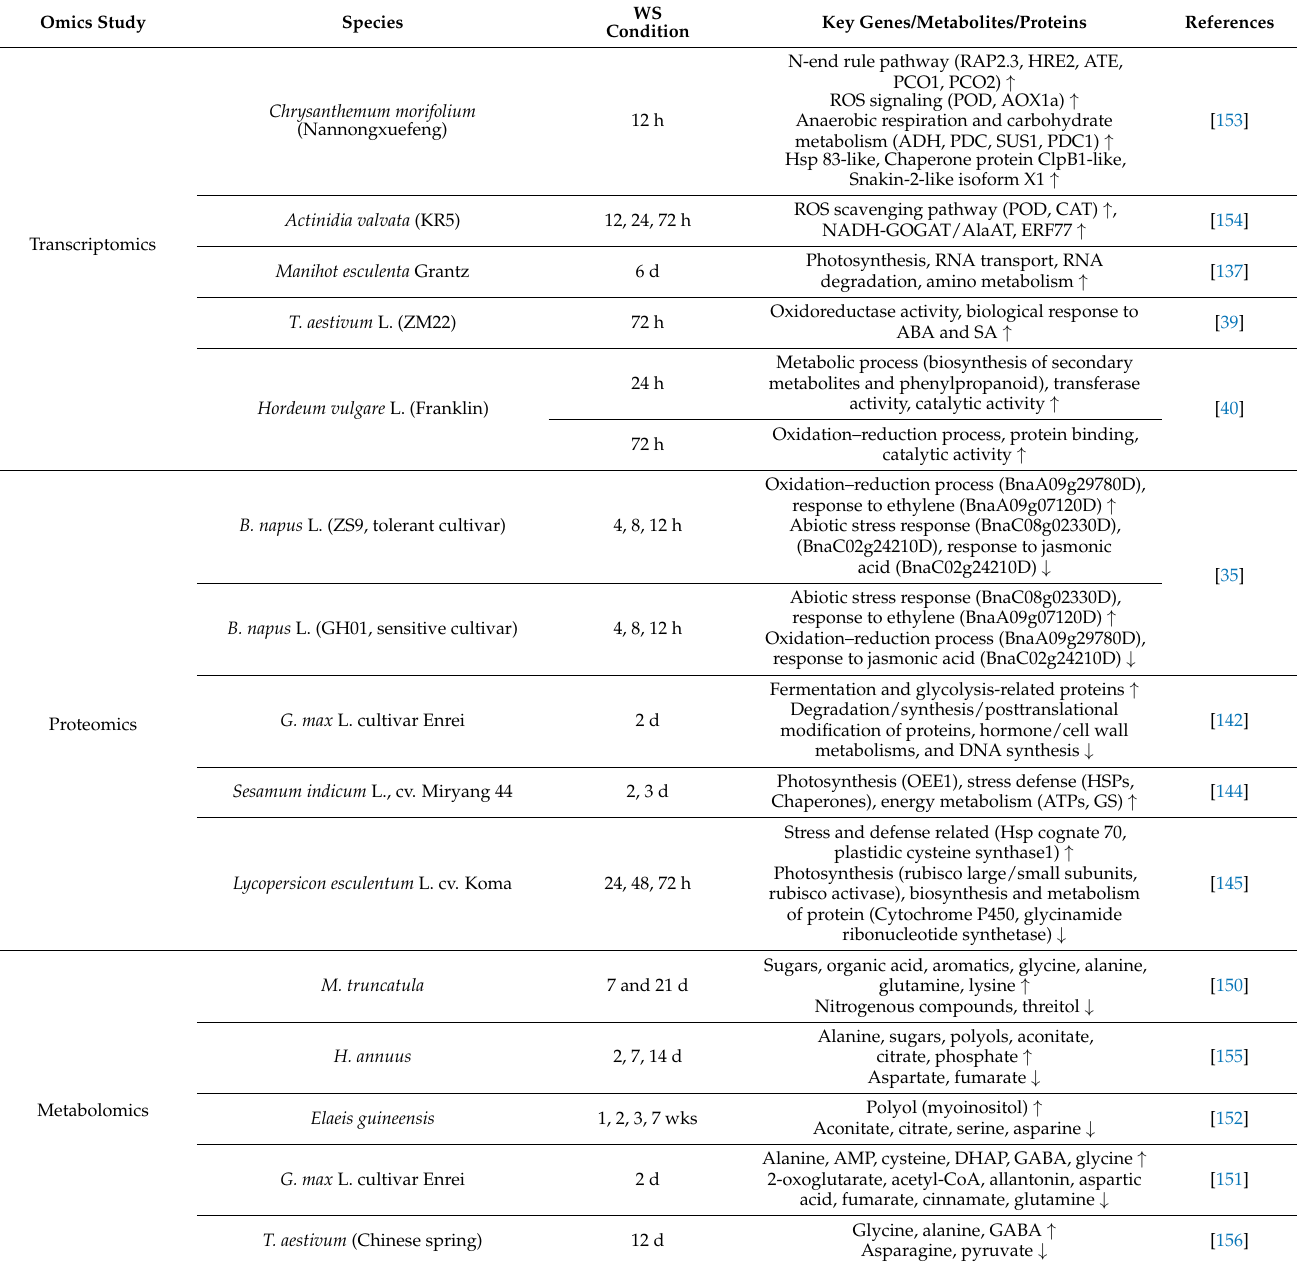
Table 4. Role of omics tools in deciphering waterlogging signaling mechanism in different crop